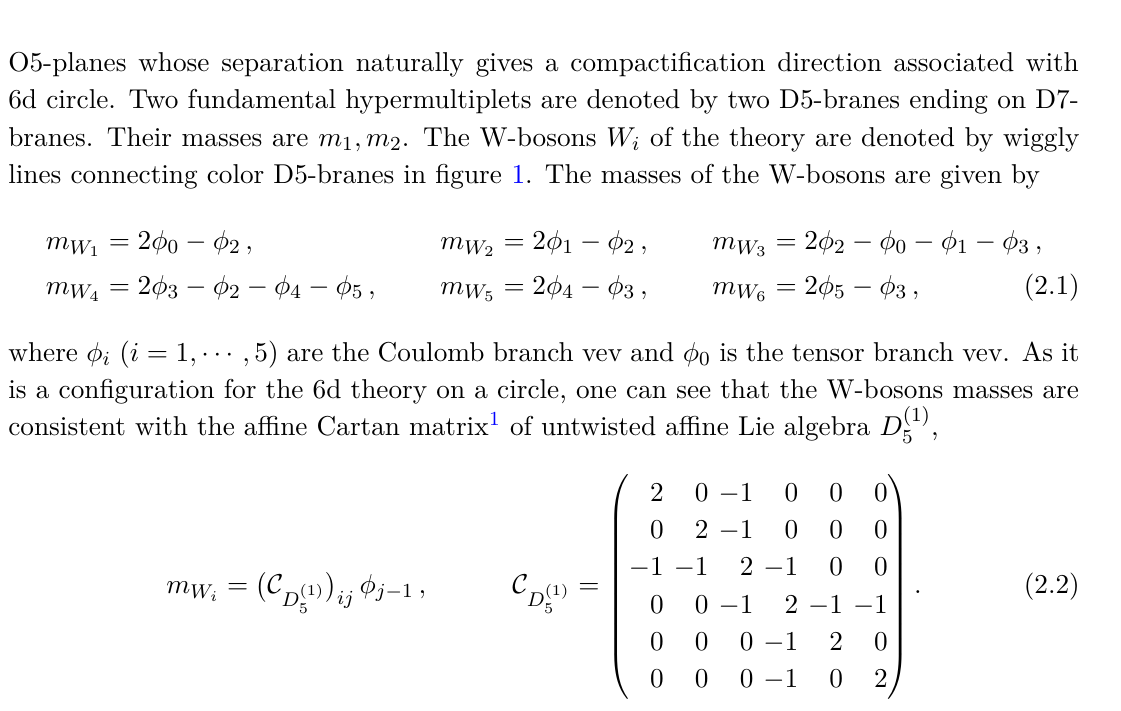
Figure 1. A 5-brane web for 6d SO(10) theory with two fundamentals. Two fundamental hyper- multiplets are represented by two external D5-branes ending on a D7-brane (black dot) and the monodromy cuts of D7-branes point the outward